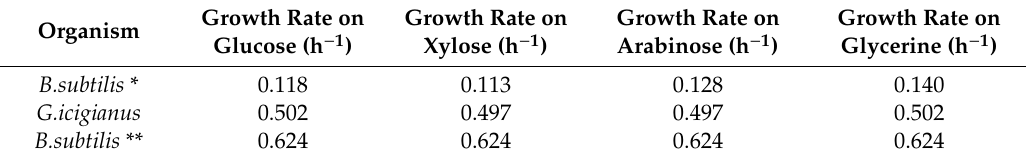
Table 2. Comparison of parsimonious flux balance analysis (pFBA) predictions for iMK1321 and i YO844 models on di ff erent